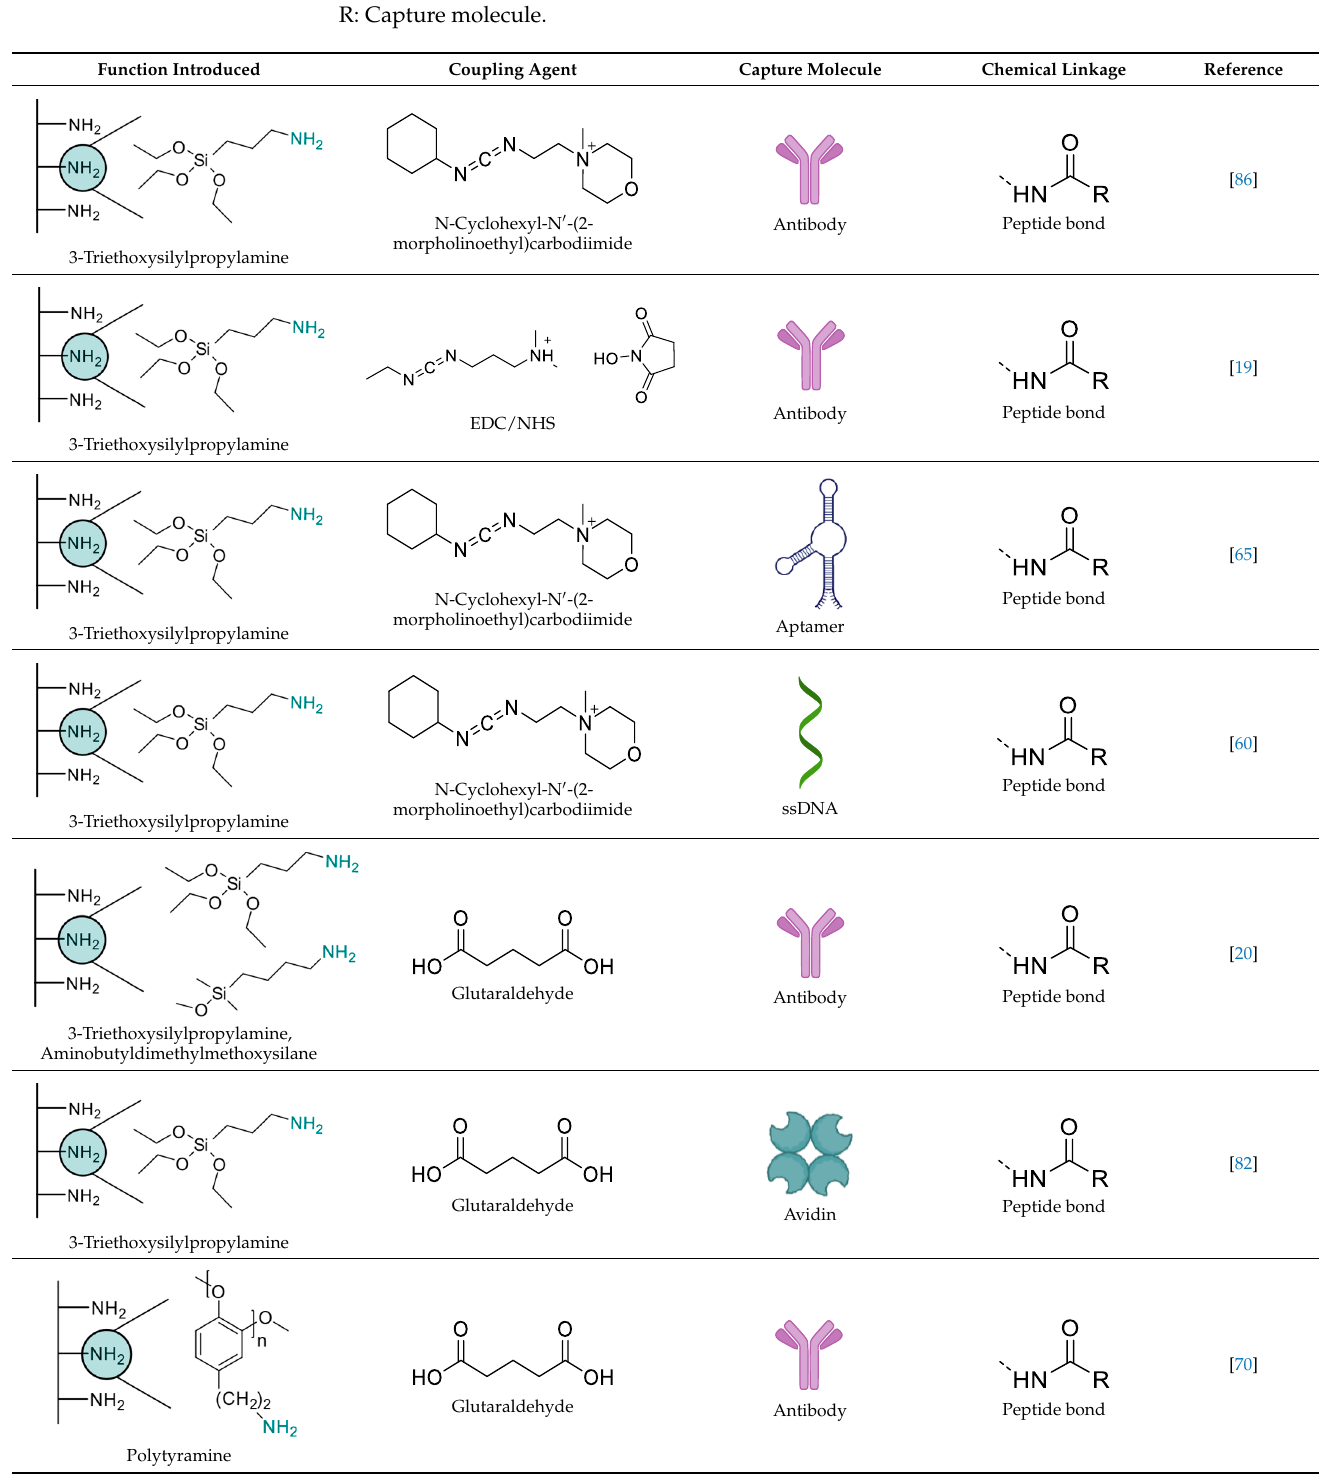
Table 2. Methods reported for the covalent conjugation of capture biomolecules on insulating layers. R: Capture molecule.